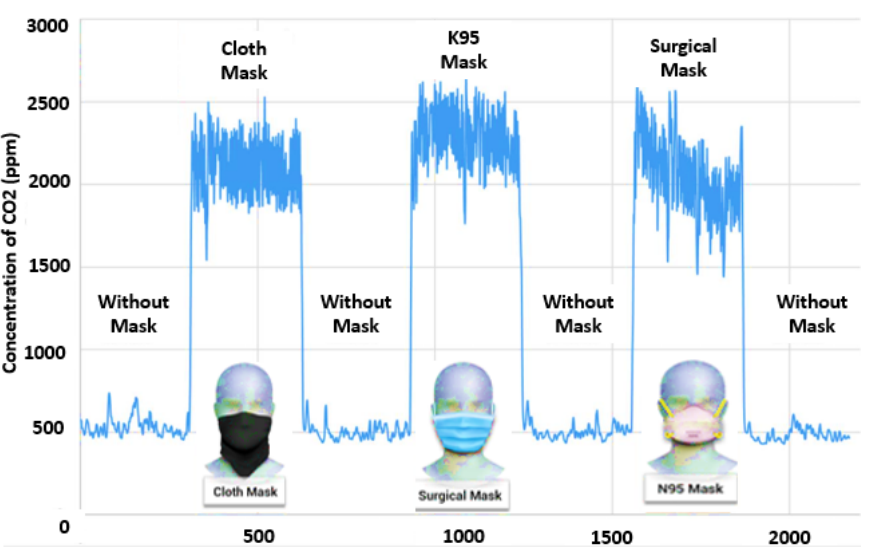
Figure 1. The Model Optimization is based on gradients in Temperature and